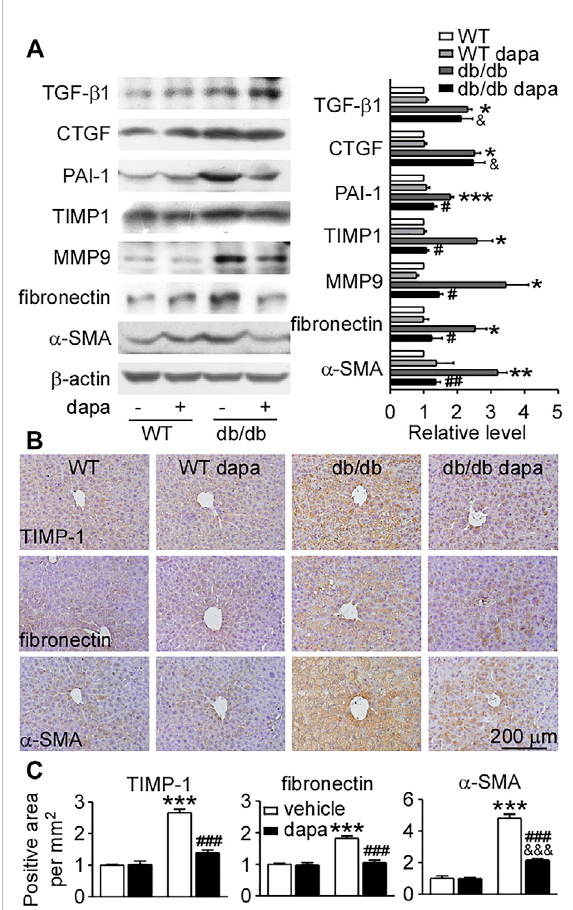
FIGURE 6 Dapagli fl ozin protected against fi brosis in the liver of db/db mice. (A) Representative western blotting ( left ) and quanti fi cation of the expression levels ( right ) of proteins associated with fi brosis in livers. (B) Immunohistochemistry showing the expression of TIMP-1, fi bronectin, and α -SMA in livers. (C) Relative level of integrated optical densities (IODs) of TIMP-1, fi bronectin, and α - SMA. Values were mean ± SEM, n = 3. * p < 0.05, ** p < 0.01, and *** p < 0.001 vs. wild-type (WT) mice. # p < 0.05, ## p < 0.01, and ### p < 0.01 vs. db/db mice. & p < 0.05, && p < 0.01, and &&& p < 0.001 vs. dapagli fl ozin-treated wild-type mice. One-way ANOVA, Bonferroni ’ s multiple comparison test. TIMP-1 = tissue inhibitor of metalloproteinase-1; α -SMA = α -smooth muscle